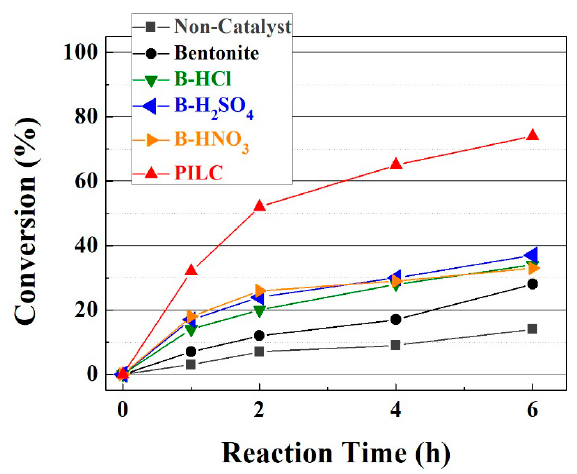
Figure 5. FACO to esters conversion in the esterification reaction of fatty acids from castor oil (FACO) with EH. Catalytic conditions: EH:FACO molar ratio of 1.5, reaction temperature: 50 °C, catalyst loading: 6 g catalyst per 100 g of FACO.